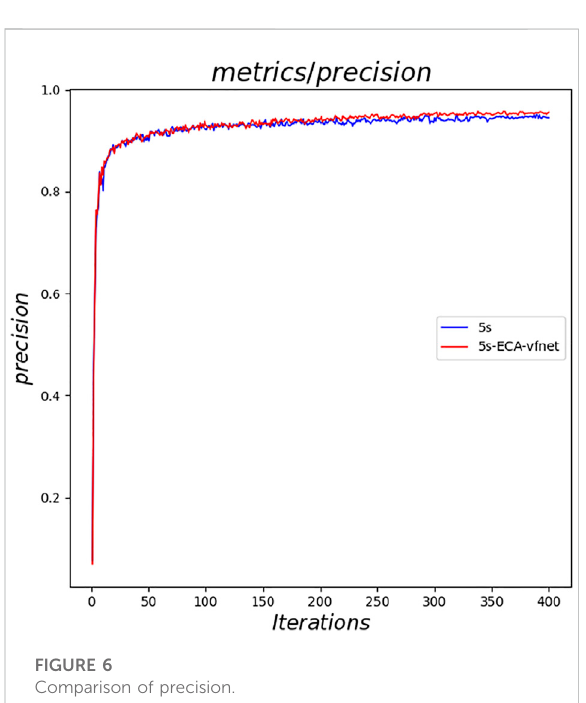
FIGURE 8 Comparison of